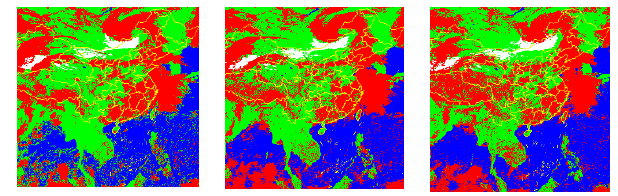
Figure 5 . The supervised classification image of on May 5, 2016. From left to right, they are 3:00, 5:00, 7:00UTC.